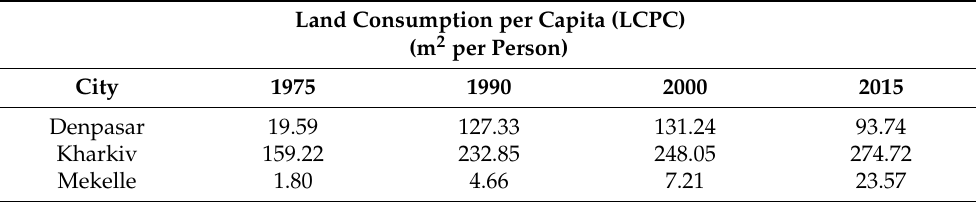
Table 7. Land consumption per capita (LCPC) per square meter (UN HABITAT, 2016b). Land Consumption per Capita (LCPC) (m 2 per